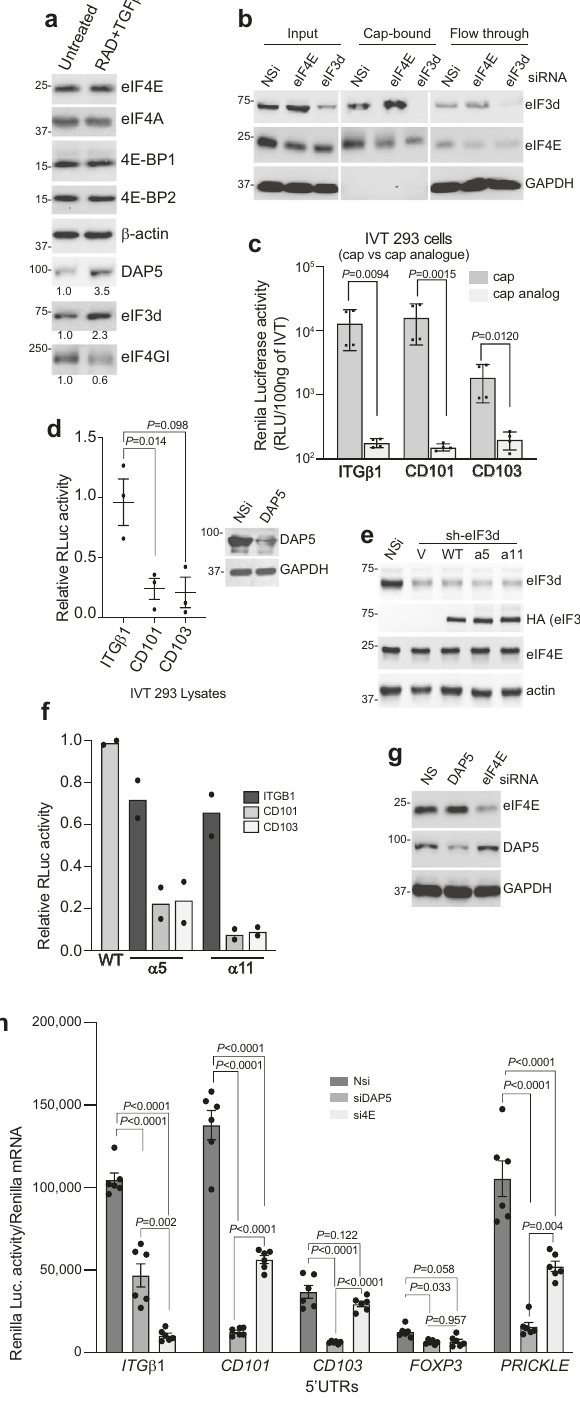
transcription containing either a functional m 7 GTP cap or a non- functional ApppG cap analog and were 3 ’ polyadenylated. Equal amounts of each mRNA were used to program 293 T cell in vitro translation extracts. Inclusion of a non-functional cap analog abolished translation activity of all mRNAs, demonstrating that Treg cell CD101 and CD103 mRNAs are cap-dependent yet able to translate despite 4E-BP inhibition of eIF4E in differentiating Treg cells. To test whether CD101 and CD103 mRNAs instead use the DAP5/eIF3d complex, in vitro translation extracts from 293 T cells NATURE COMMUNICATIONS| (2021) 12:6979